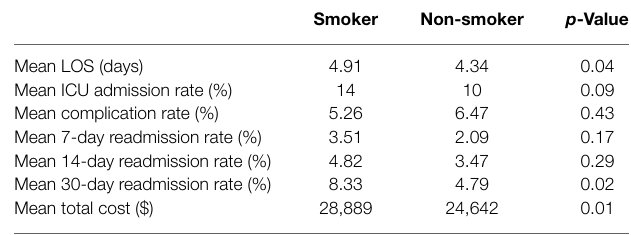
TABLE 1 | Outcomes of patients admitted for spinal treatment for dorsopa- thy .